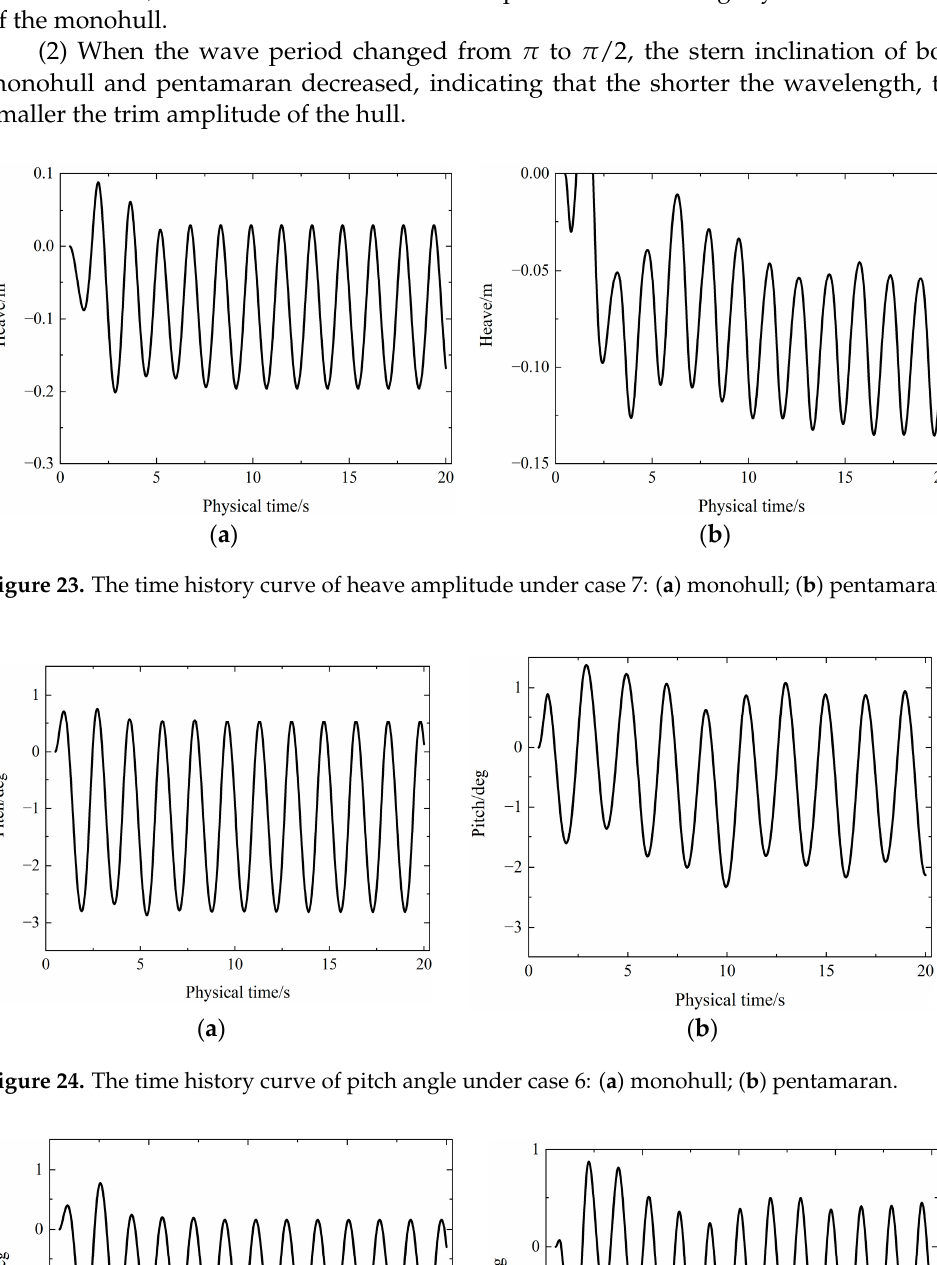
Figure 22. The time history curve of heave amplitude under case 6: ( a ) monohull; ( b ) pentamaran.